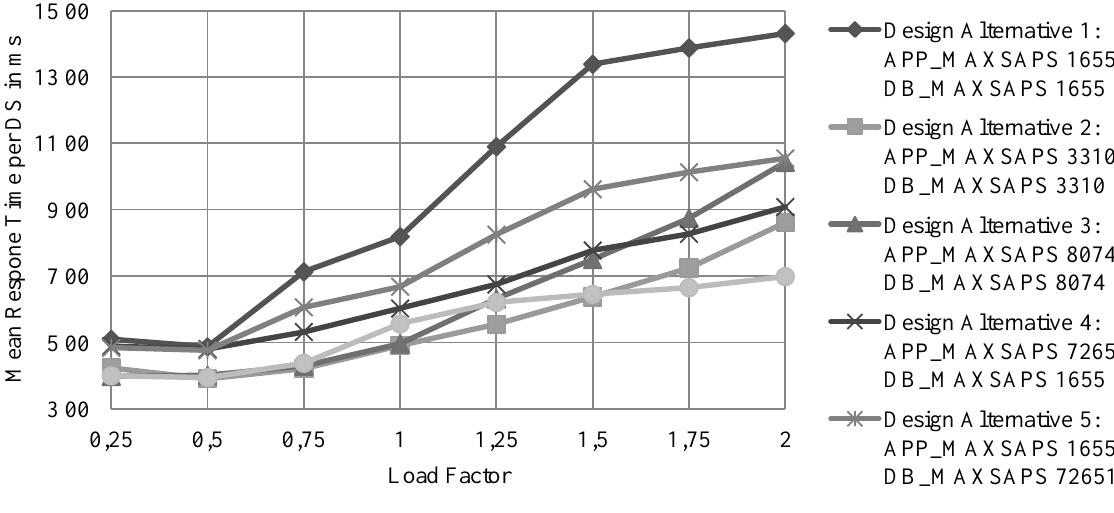
Figure 3. Performance prediction results for alternative